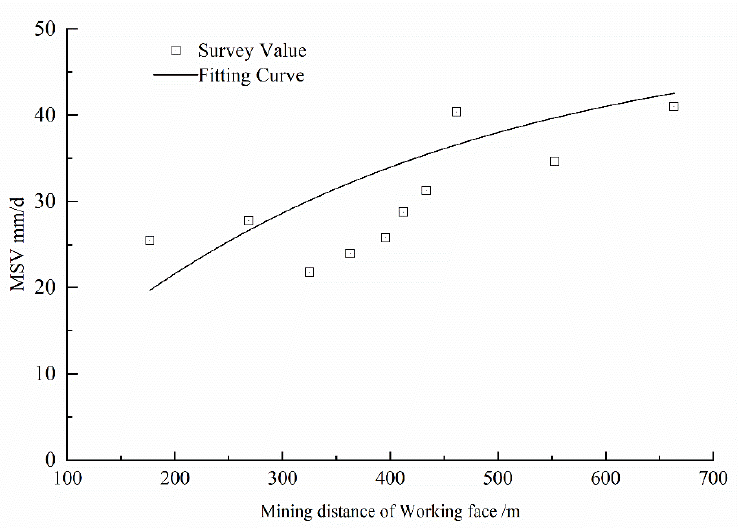
Figure 4. Maximum subsidence velocity (MSV) curve of the surface survey line.